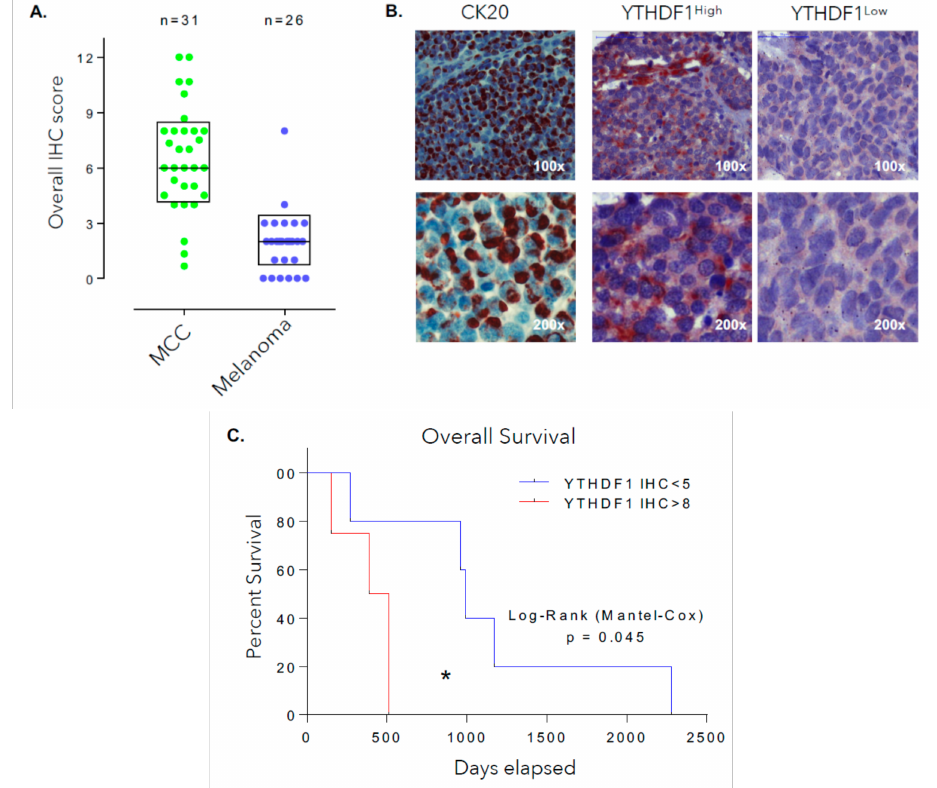
Figure 2. ( A ) YTHDF1 protein expression data from a cohort of 31 MCC patients compared to its expression in 26 melanoma patients. Data analyzed from tissue microarrays consisting of 3–6 replicates for each tumor sample from various sites of each tumor (total of 213 tumor cores). ( B ) Immunostaining showing expression of YTHDF1 in two samples expressing this protein at high and low level along with CK20 in a patient’s tumor specimen at di ff erent magnifications. ( C ) Comparison of overall survival data in two groups of YTHDF1 high (immunohistochemistry (IHC) score > 8) and YTHDF1 low (IHC score < 5) patient samples from those with available survival data (log-rank p value = 0.045), p < 0.05 is shown with